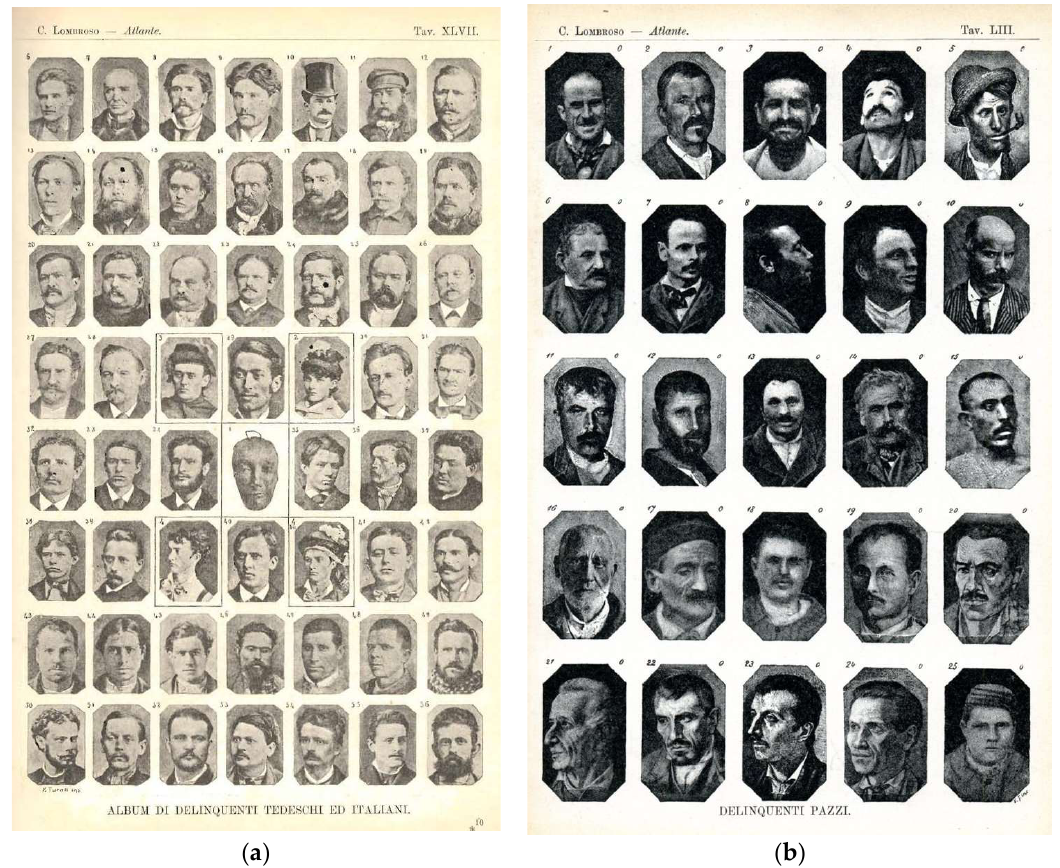
Figure 3. ( a , b ) Argumentative photographic comparisons of Lombroso’s